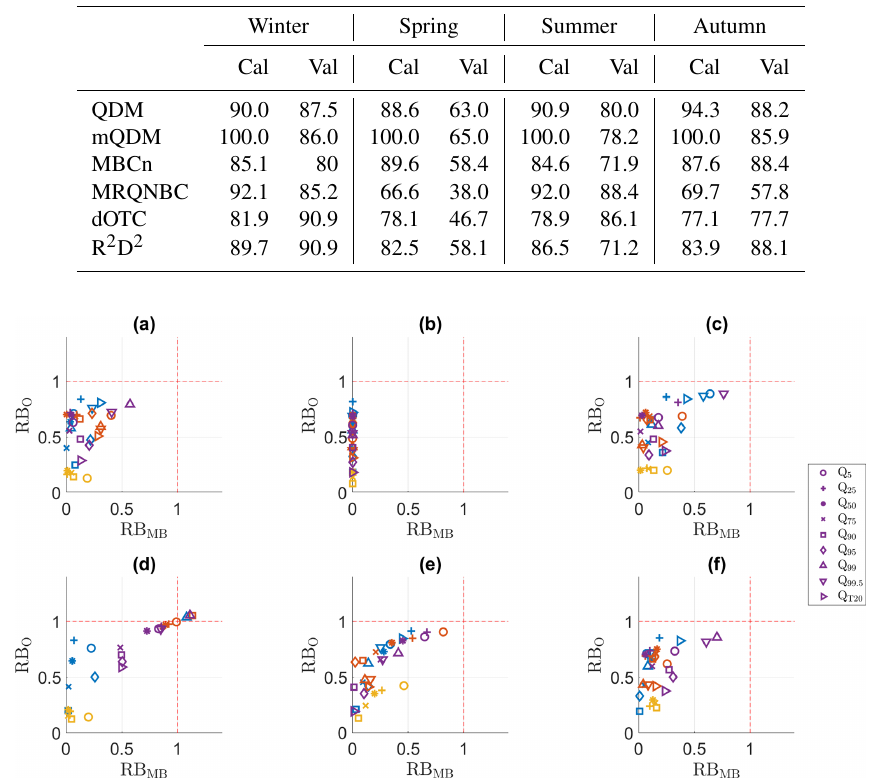
Figure 10. RB MB versus RB 0 for the discharge percentiles and the 20-year return period value in the calibration period. (a) QDM, (b) mQDM, (c) MBCn, (d) MRQNBC, (e) dOTC, (f) R 2 D 2 . Winter: blue, spring: ochre, summer: yellow, autumn: